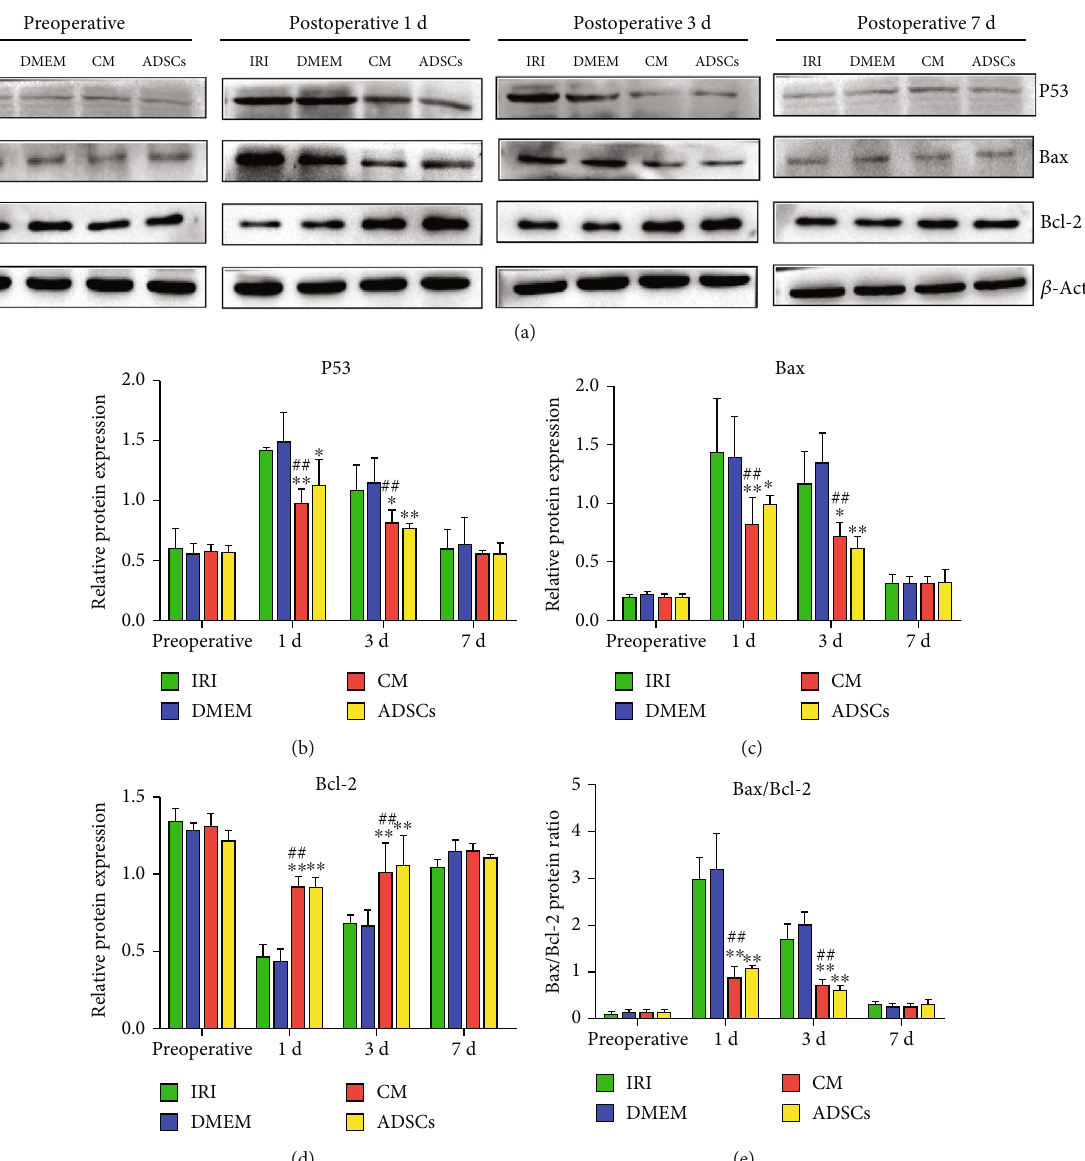
Figure 6: Expression levels of apoptosis-related proteins in liver tissue: (a) representative immunoblot showing P53, Bax, Bcl-2, and β -actin levels in the indicated groups. (b – e) Quanti fi cation of P53, Bax, Bcl-2, and Bax/Bcl-2 ratio. ∗ P < 0 : 05 and ∗∗ P < 0 : 01 compared to IRI group; # P < 0 : 05 and ## P < 0 : 01 compared to DMEM